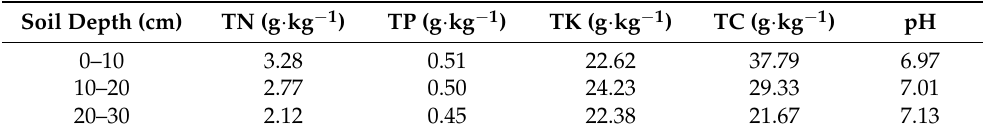
Figure 1. Monthly average temperature and precipitation in the experimental area for 2021. Table 1. Soil basic properties indicator of the test site.